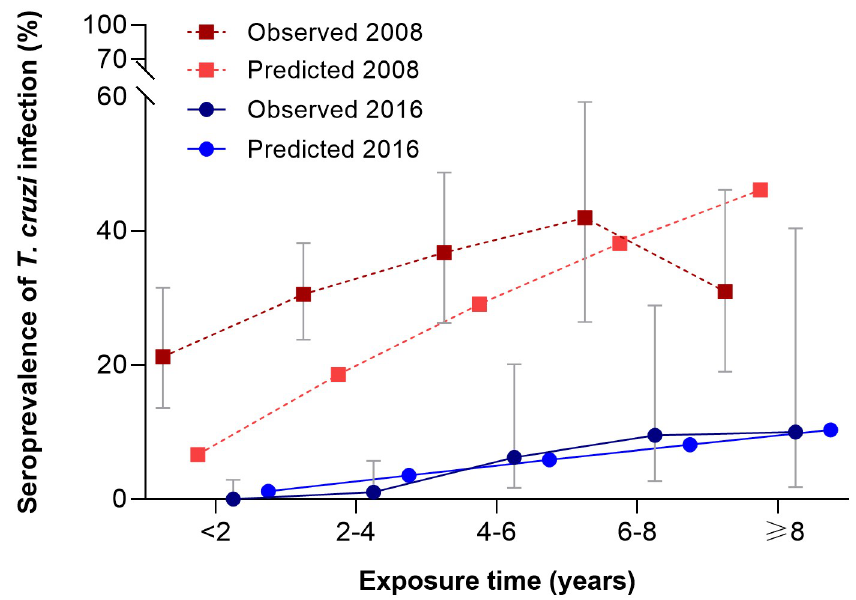
Fig 4. Age-specific seroprevalence of Trypanosoma cruzi infection in dogs, Pampa del Indio, Chaco, 2016. Expected seroprevalence derives from the irreversible catalytic